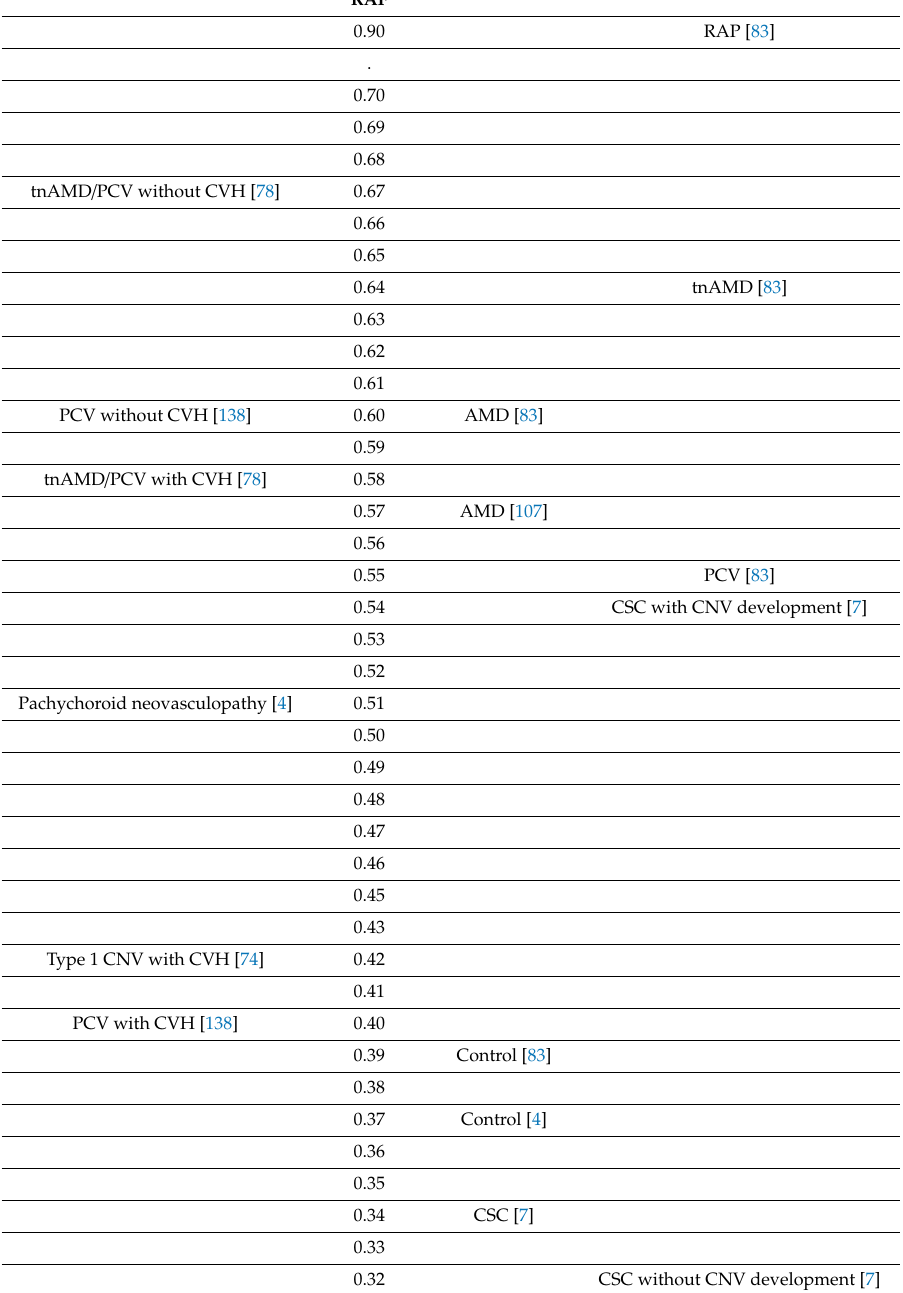
Table 7. Previously reported risk allele frequencies of ARMS2 A69S in